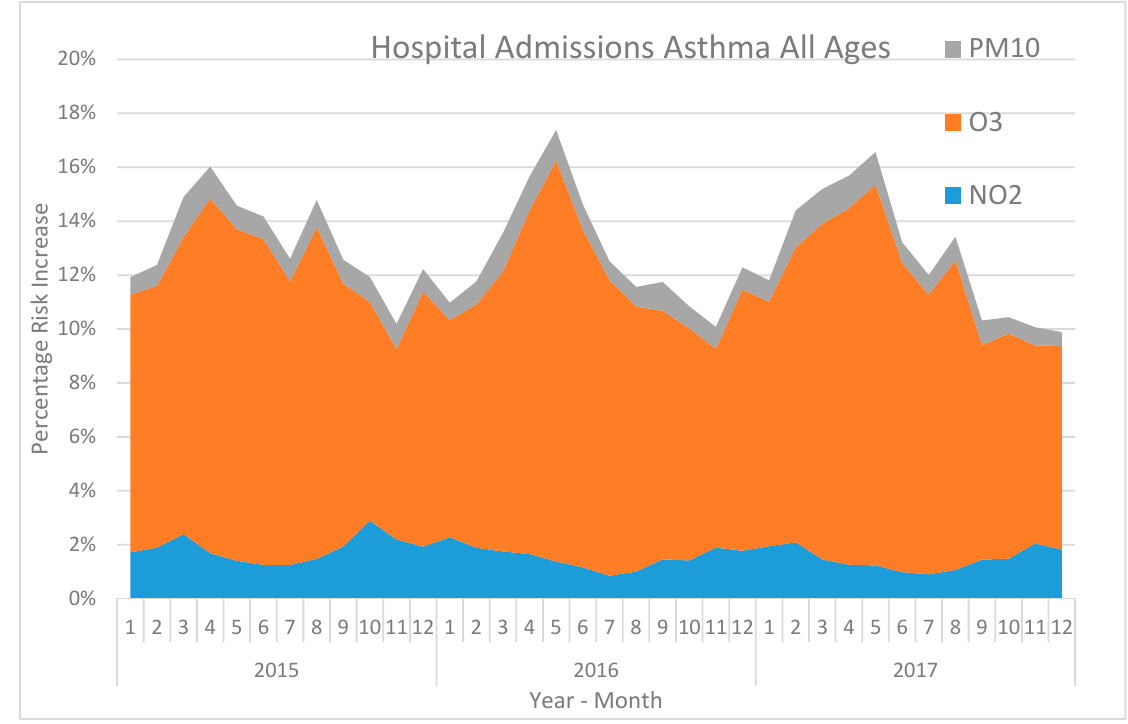
Figure 3. The calculated average monthly percentage risk increase associated with NO 2 , O 3 , and PM 10 for cardiovascular mortality in all ages in Stockholm during 2015–2017 based on meta-coefficients [8].